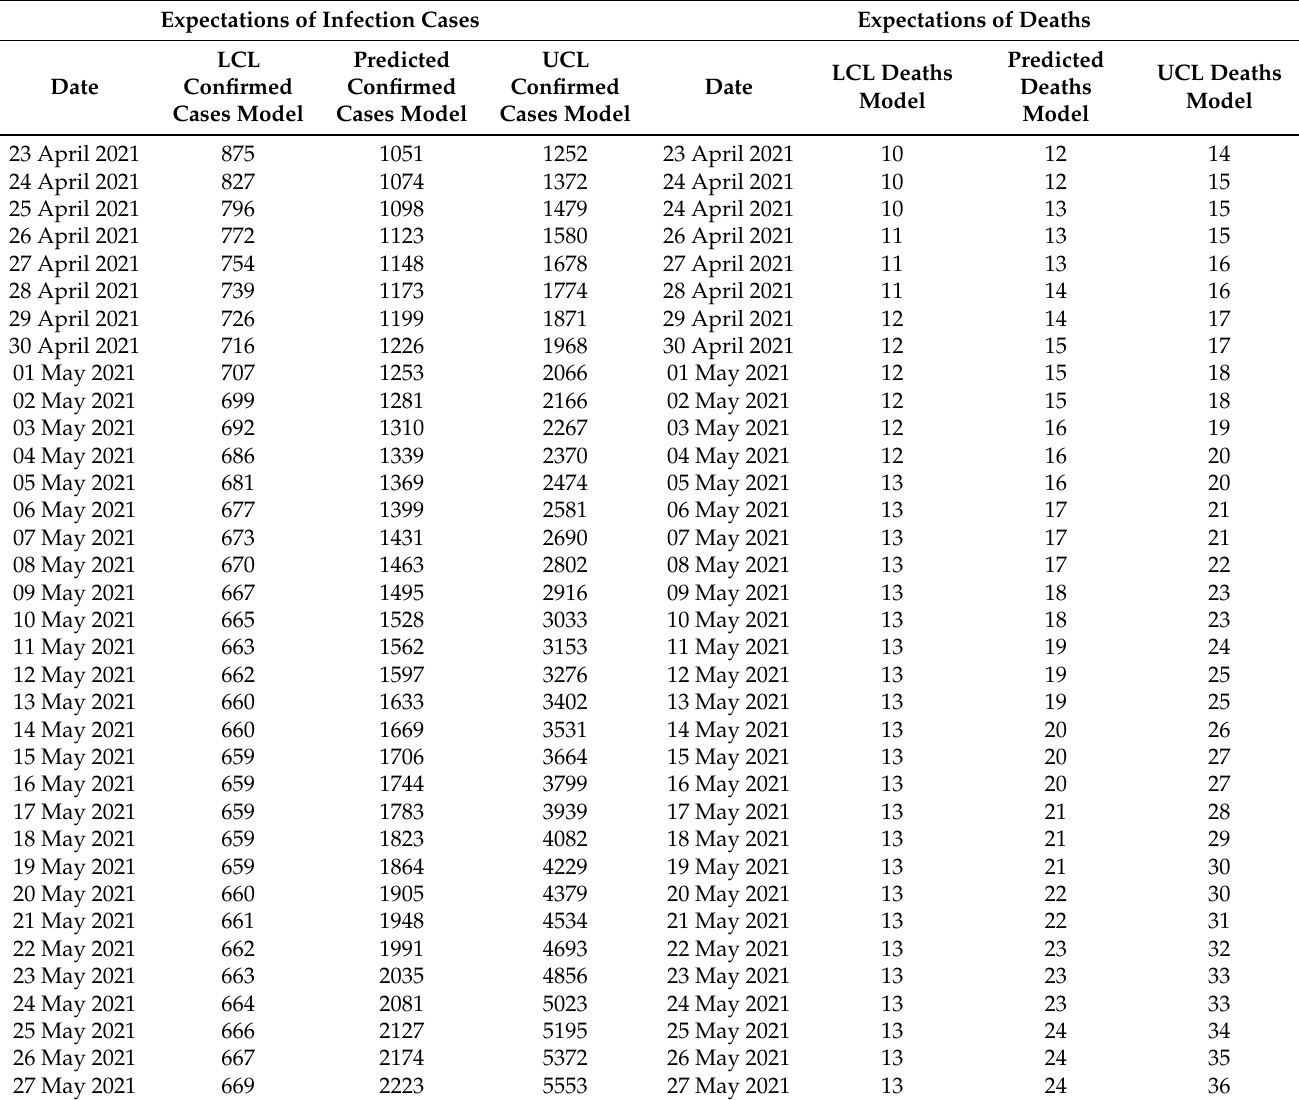
Table 5. Expectations of confirmed cases and deaths with their upper and lower limits for COVID-19 in Saudi Arabia for the period from 23 April 2021 to 31 May